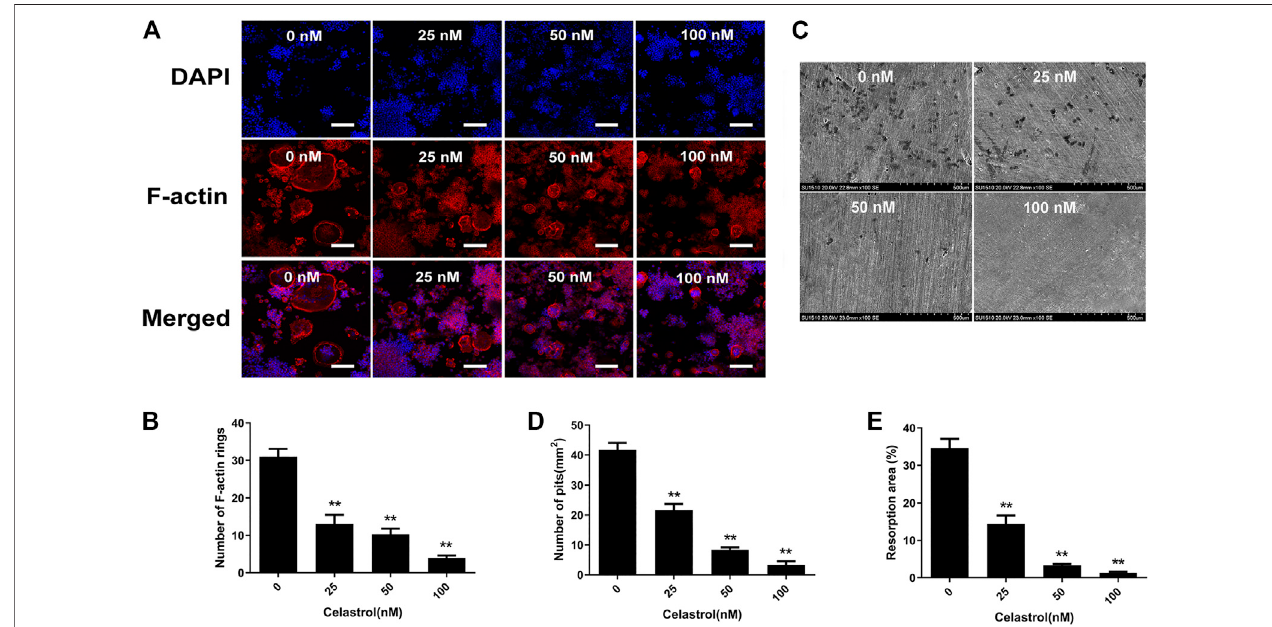
FIGURE 2 | Celastrol supressed F-actin ring formation and bone resorption. Effects of celastrol on the formation of the F-actin ring. RAW264.7 cells were treated with50 ng/ml RANKL without or with the speci fi ed concentrations of celastrol and were then fi xed and immunostained for the F-actin ring. (A) Representative images of immuno fl uorescent microscopyshowing theF-actin(red) and nuclei (blue) in celastrol-treated osteoclasts. Scalebar (cid:2) 200 μ m. (B) Quanti fi cation of thenumber ofactin rings. (C) Effects of celastrol on osteoclastic bone resorptive function. RAW264.7 cells were stimulated with 50 ng/ml RANKL for three days. The cells were later culturedinthespeci fi edconcentrationsofcelastrolwith50 ng/mlRANKLforanother48 h.Resorptionpitswerevisualizedbyscanningelectronmicroscopy.Scalebar (cid:2) 500 μ m. (D – E) The bone resorption (numbers and areas) for each treatment condition were quanti fi ed. All experiments were carried out three times, and all data are showed as the means ± SD; * p < 0.05, ** p <